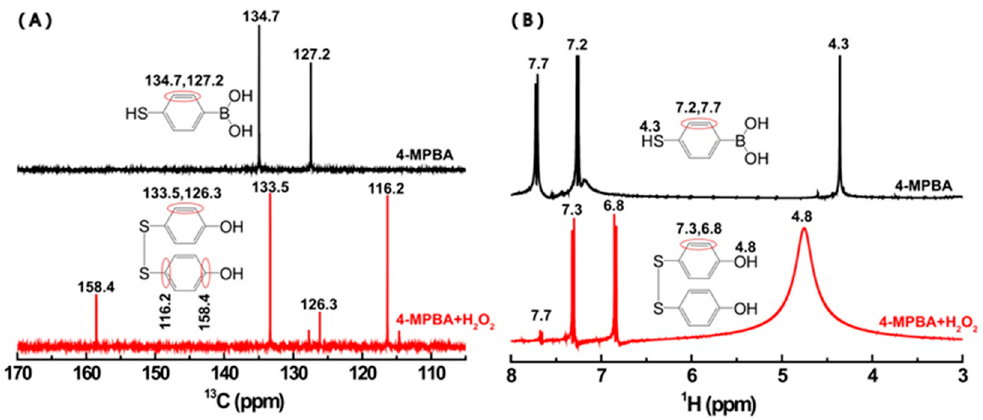
Figure 8. The 1 H and 13 C spectra for the reaction solution of 4 ‐ MPBA and H 2 O 2 (0.15 M 4 ‐ MPBA, 0.94 Figure 8. The 13 C ( A ) and 1 H ( B ) spectra for the reaction solution of 4-MPBA and H 2 O 2 (0.15 M M H 2 O 2 ) in the late reaction period. 4-MPBA, 0.94 M H 2 O 2 ) in the late reaction